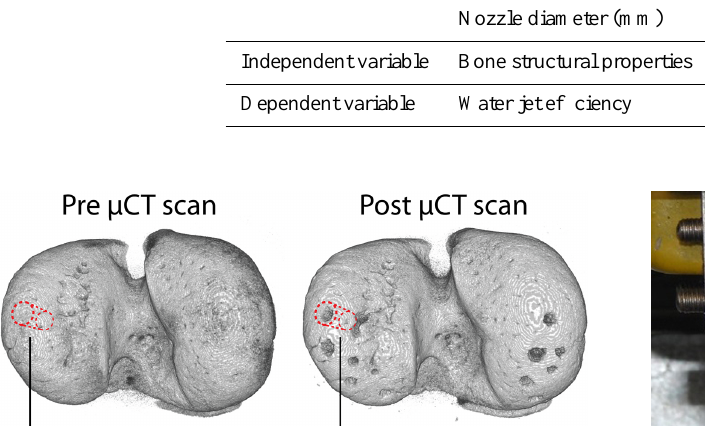
Table 1. The experiment variables and factors.